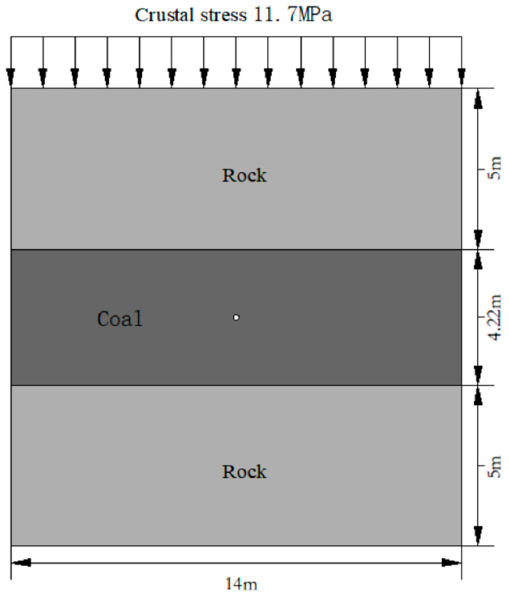
Figure 3. Coal and gas coupling geometric model.